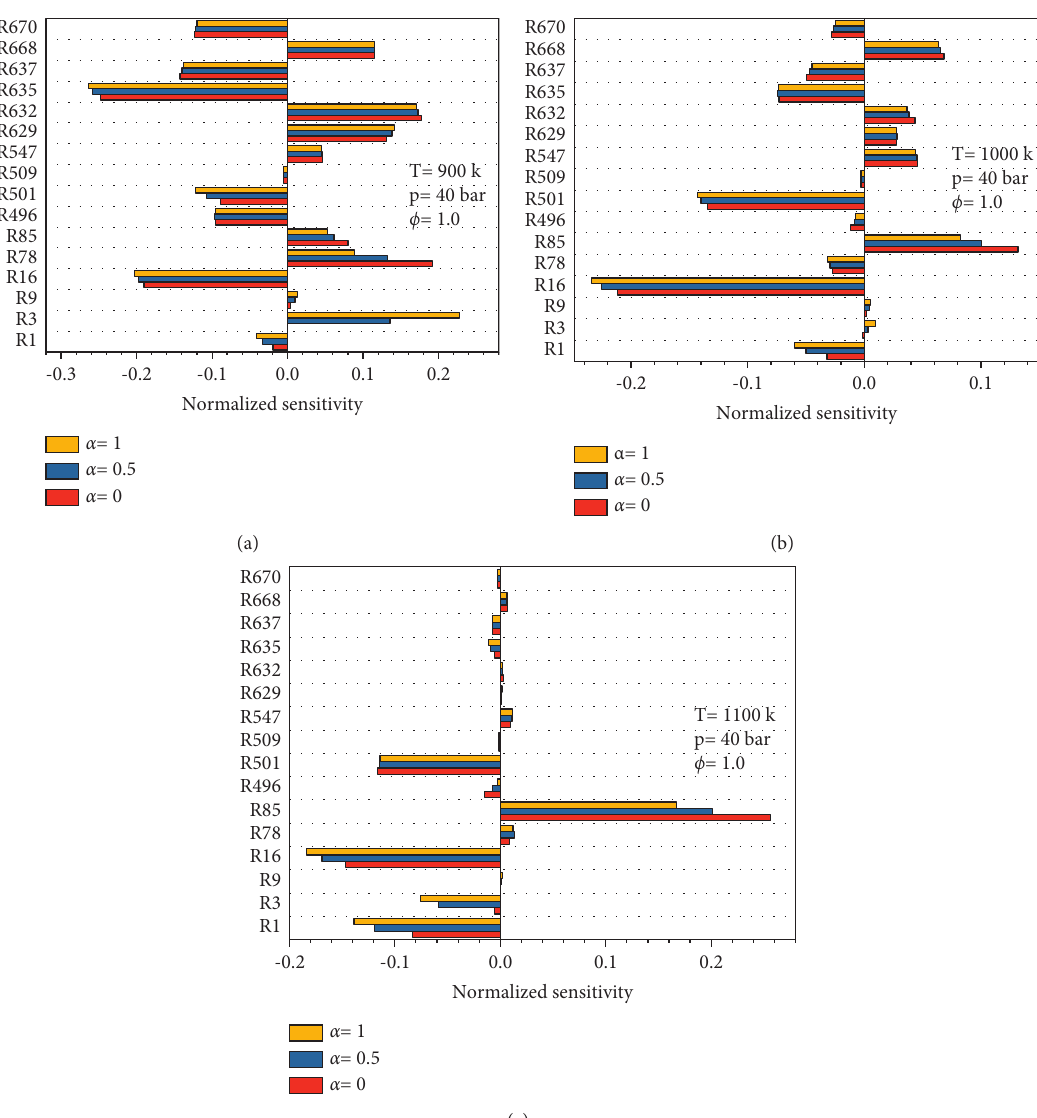
Figure 10: Reaction sensitivity analysis of the ignition delay time for various α values in the different temperature ranges for methane/H heptane mixtures at β � 4.545 × 10 − 2 , p � 40 bar, and ϕ �